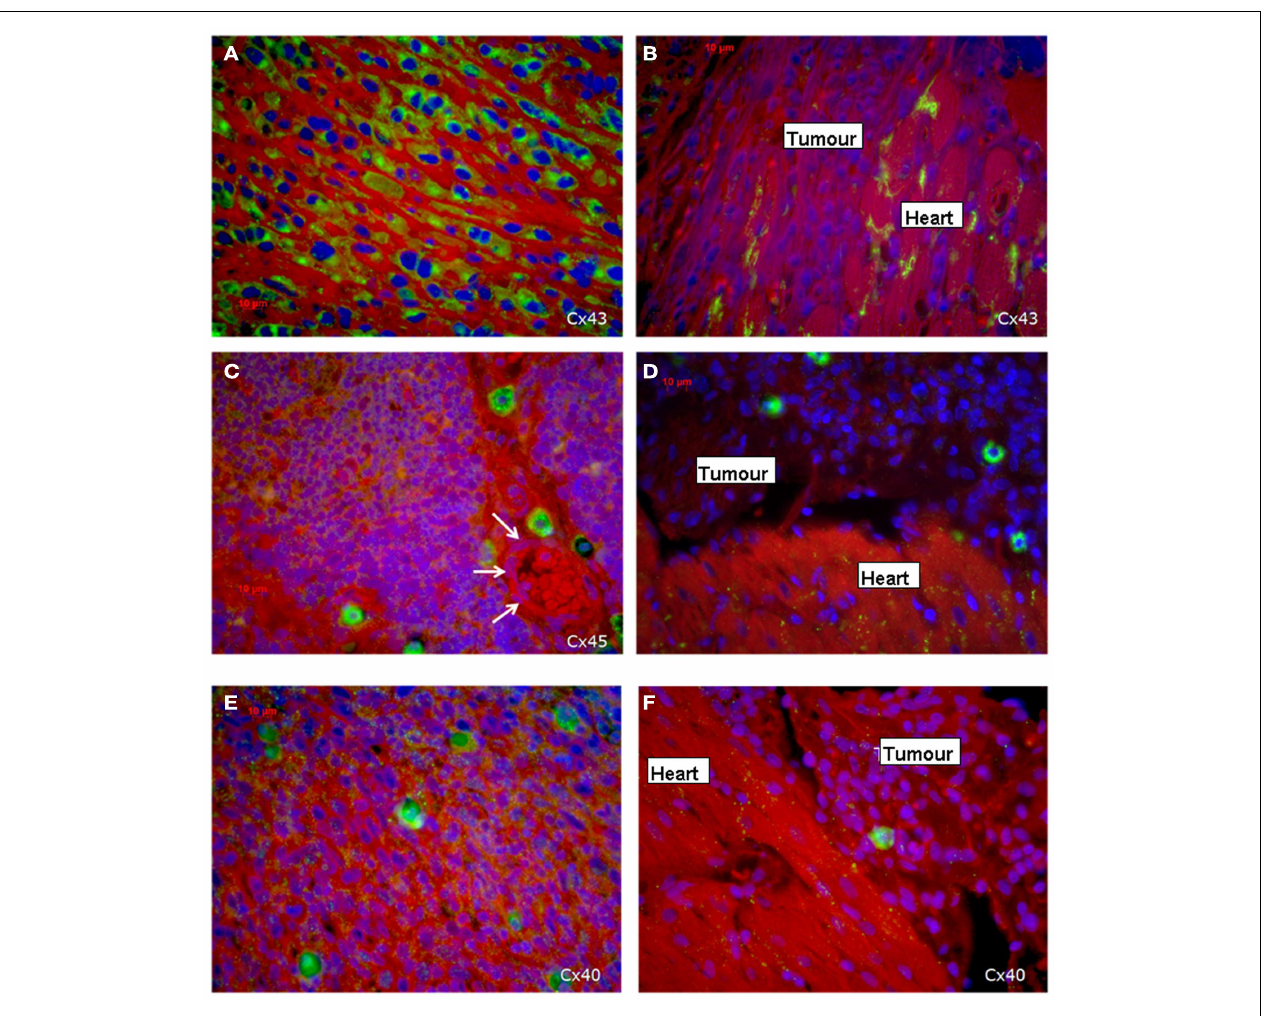
loss of connexin expression in the invading zone of the tumor close to the heart and a regular distribution of connexins in the heart itself.The white arrows indicate a